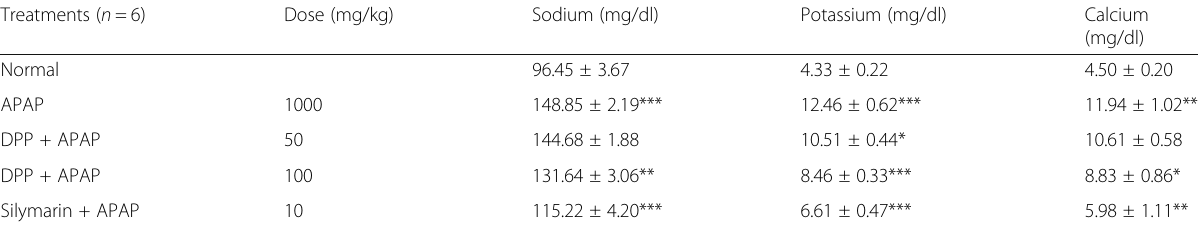
Table 4 Effect of DPP on APAP-intoxicated rats serum sodium, potassium and calcium